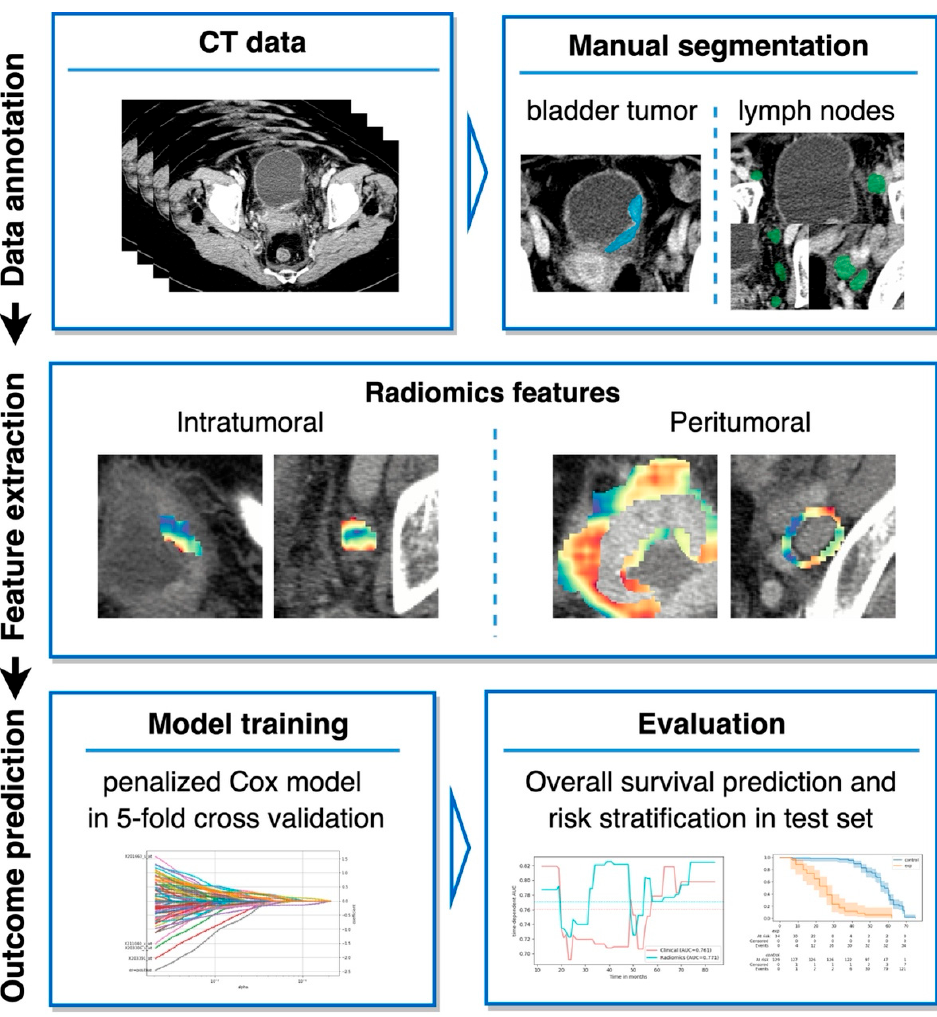
Figure 2. Study design.